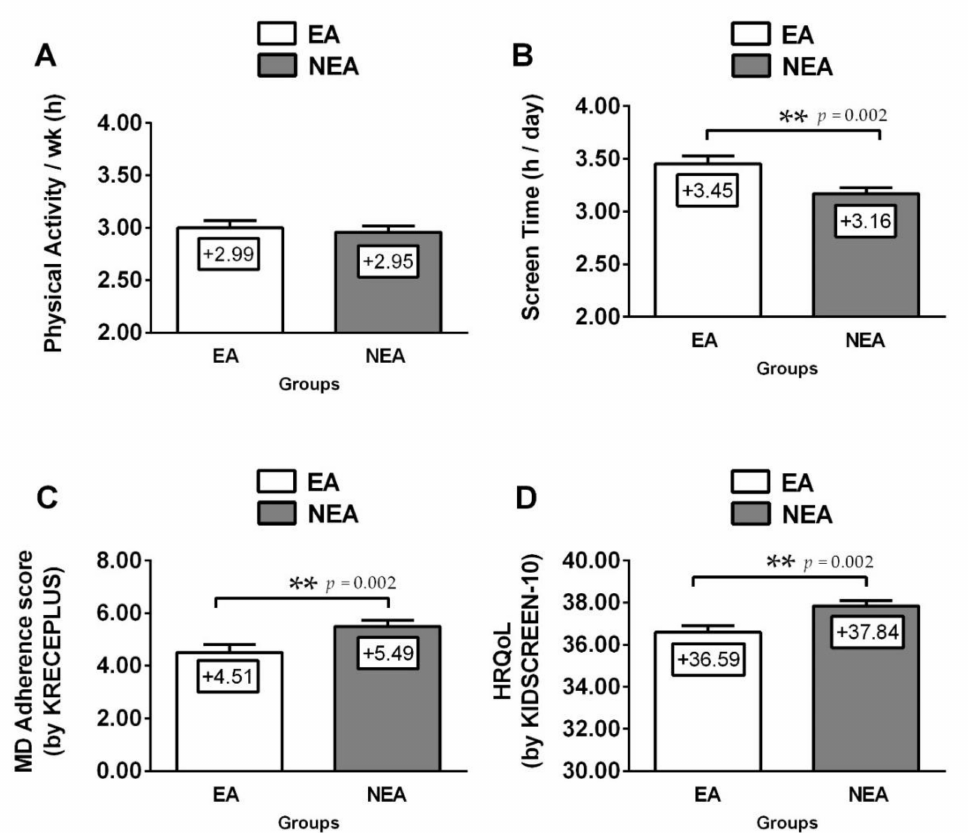
Figure 2. Lifestyle’s parameters ( A ) physical activity level per week, ( B ), screen time per day, and panel adherence to mediterranean diet ( C ), and health-related quality of life score ( D ) in schoolchildren participants by ethnicity. (**) Asterisks denotes significant di ff erences by group at p -values less than p < 0.01. EA = ethnic ascendants, NEA = non-ethnic ascendant schoolchildren, MD = Mediterrnean diet adherence score, HRQoL = health-related quality of life.